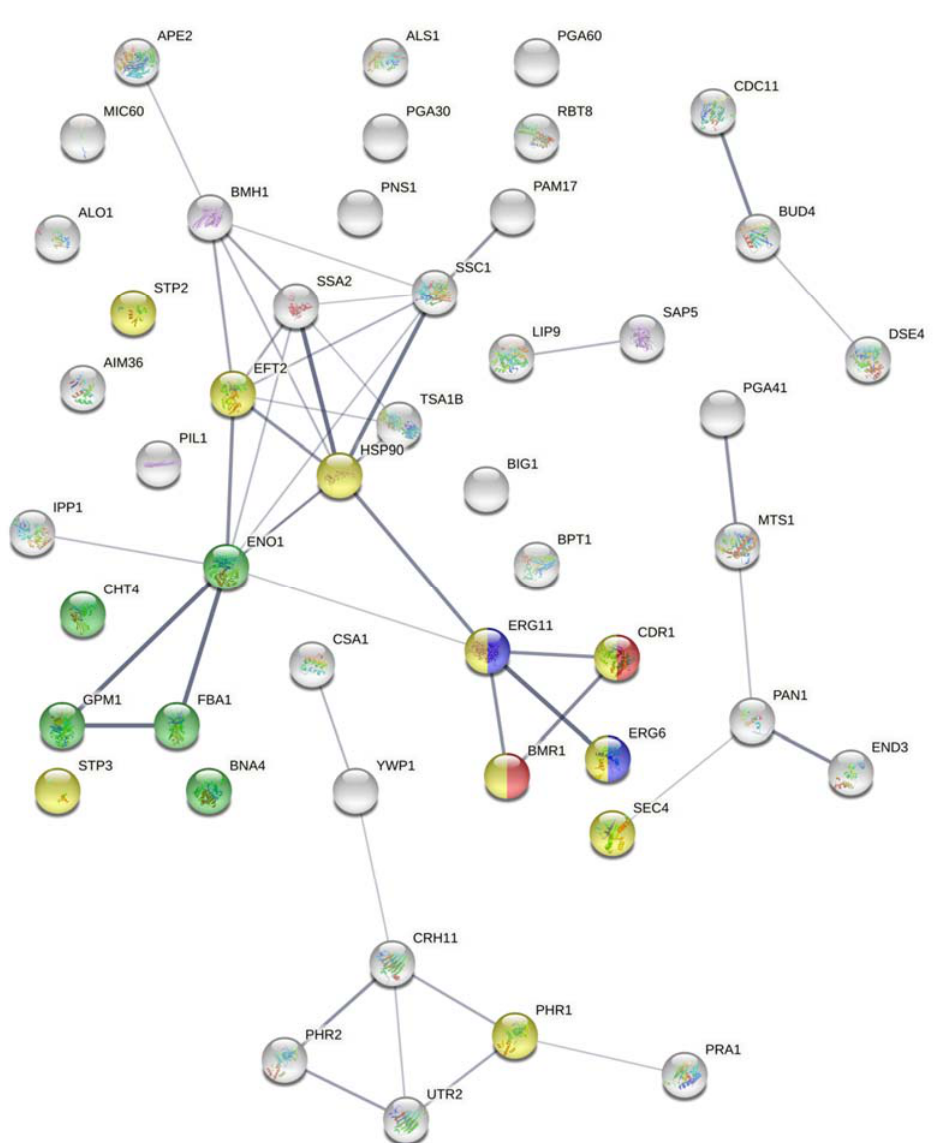
Figure 1. Prediction map of the protein–protein interactions among the identified cell wall proteins in the fluconazole- resistant C. albicans strain. The map was constructed using STRING database (version 11.0) with a minimum confidence score of 0.4 where line thickness reflects the strength of data support. Joint proteins function in interconnected pathways. Colored nodes refer to proteins with biological process related to drug metabolic process (green), cellular response to drug (yellow), response to fungicide (red), and/or ergosterol biosynthetic pathway (blue). Filled nodes refer to proteins with known or predicted structures whereas empty nodes refer to proteins with unknown structures.